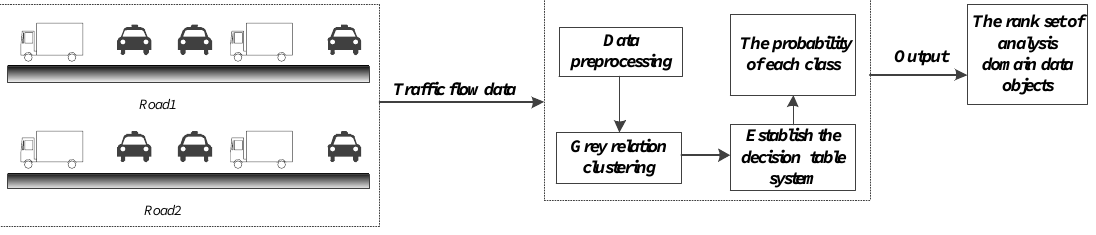
Figure 2. The architecture of the grey relational membership degree rank clustering algorithm (GMRC).